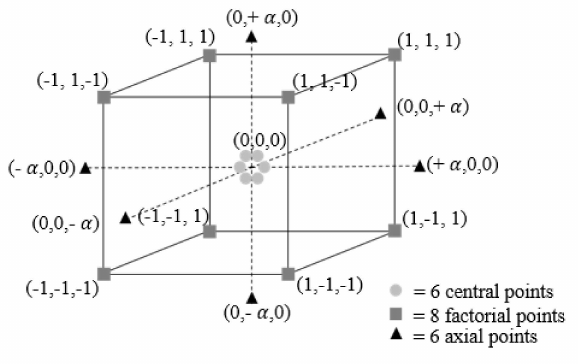
Figure 2. Central composite design with three factors and five levels